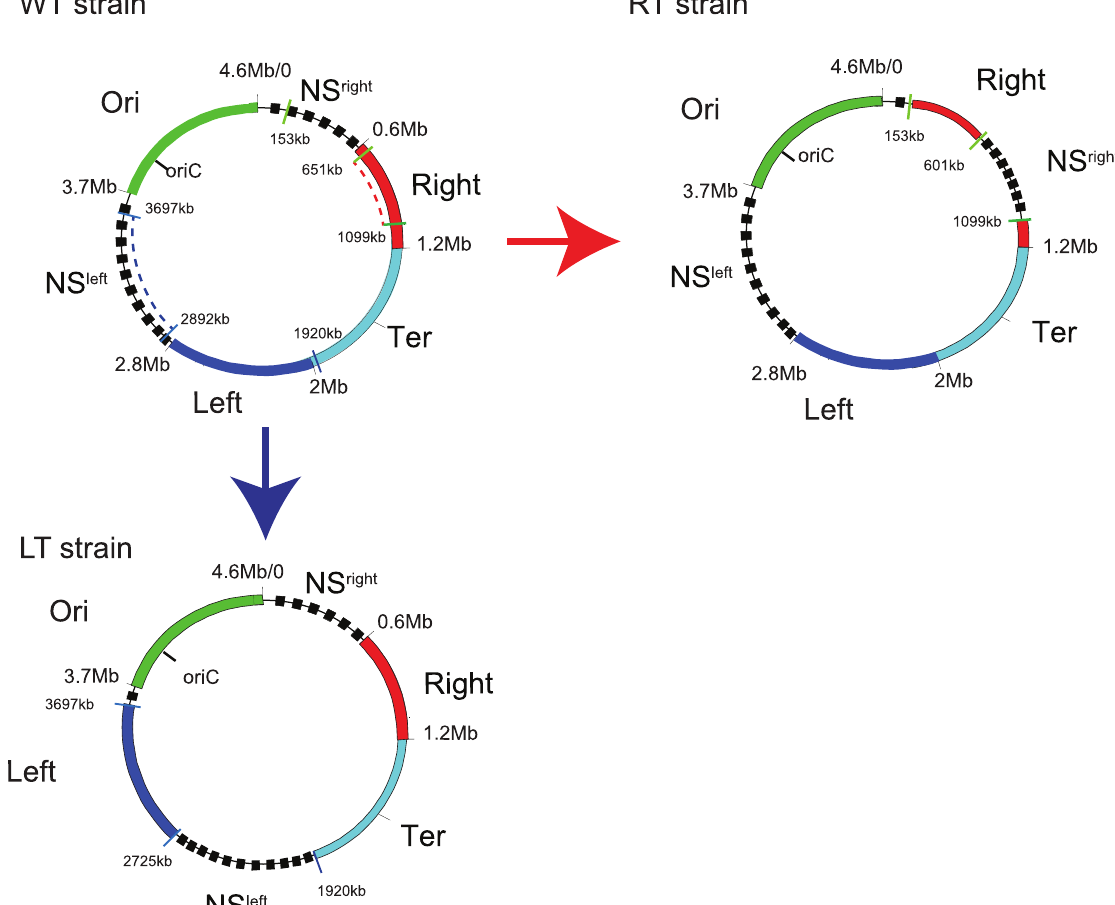
Fig 1. Chromosomal rearrangement by transposition. Chromosomal map of the 4 MDs (Ori: green, Right: red, Ter: light blue, Left: Dark blue) and the two non-structured regions (dashedblack line) in the WT strain, the Right transposed strain and the Left transposed strain. att sequencesused for the RT transposition are indicatedby the green barre, the Right fragment between attR127 (651 kb) and attLlc13 (1099 kb)(dashedred line) was transposed at the position attB O-NSR (153 kb). att sequences used for the LT transposition are marked in blue, the NSL fragment between attR124 (2892 kb) and attL146 (3697 kb, dashed blue line) was transposed at the position attB LT2 (1920 kb).